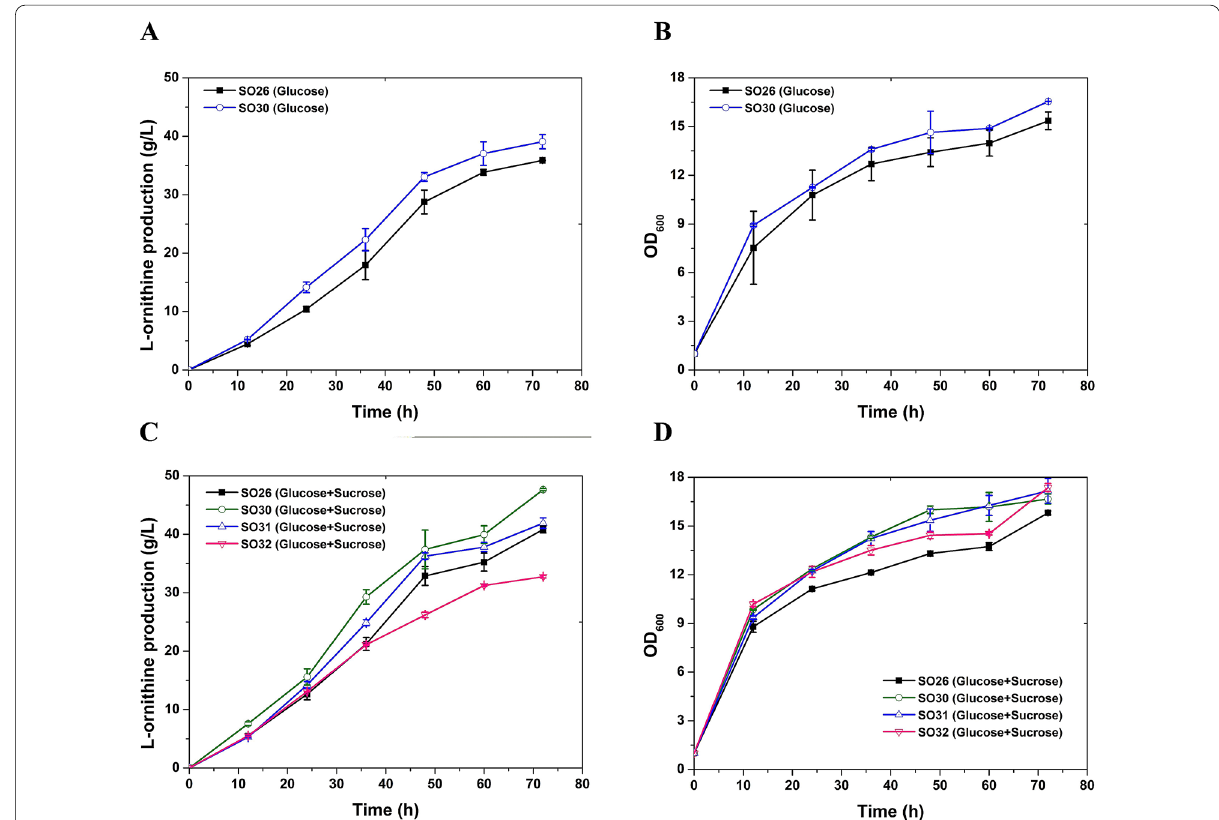
Fig. 3 Manipulation of fructose metabolic pathway promotes l -ornithine accumulation in C. glutamicum SO26. A l -Ornithine production curves of strain C. glutamicum SO26 (solid black square) and SO30 (with pfkB1 deletion, hollow blue cycle) cultivated on glucose. B Cell growth curves of strain C. glutamicum SO26 (solid black square) and SO30 (hollow blue cycle) cultivated on glucose. C l -Ornithine concentration in the fermentation liquids of strain SO26 (solid black square), SO30 (hollow green cycle), SO31 (hollow blue upper triangle), and SO32 (hollow red lower triangle) cultivated on glucose plus sucrose. D Cell growth of strain SO26 (solid black square), SO30 (hollow green cycle), SO31 (hollow blue upper triangle), and SO32 (hollow red lower triangle) cultivated on glucose plus sucrose. Data are averages and standard deviations from three independent